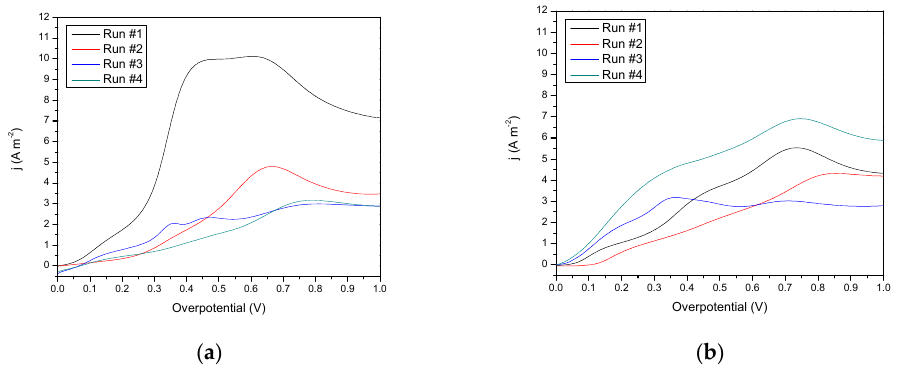
Figure 3. Linear voltammetry (1 mV s − 1 ) after 21 days of polarization at ( a ) +0.34 V/SHE and ( b ) − 0.16 V/SHE.